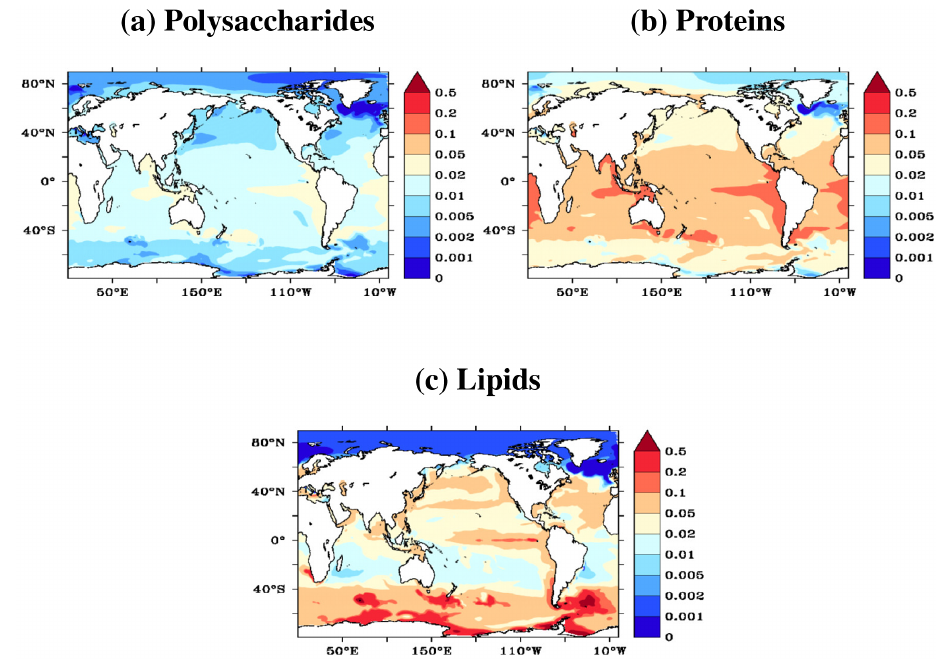
Figure 8. Submicron SSA dry mass fraction from each compound class for February (BASE case). Fractions of processed and humic classes (not shown) are negligible.